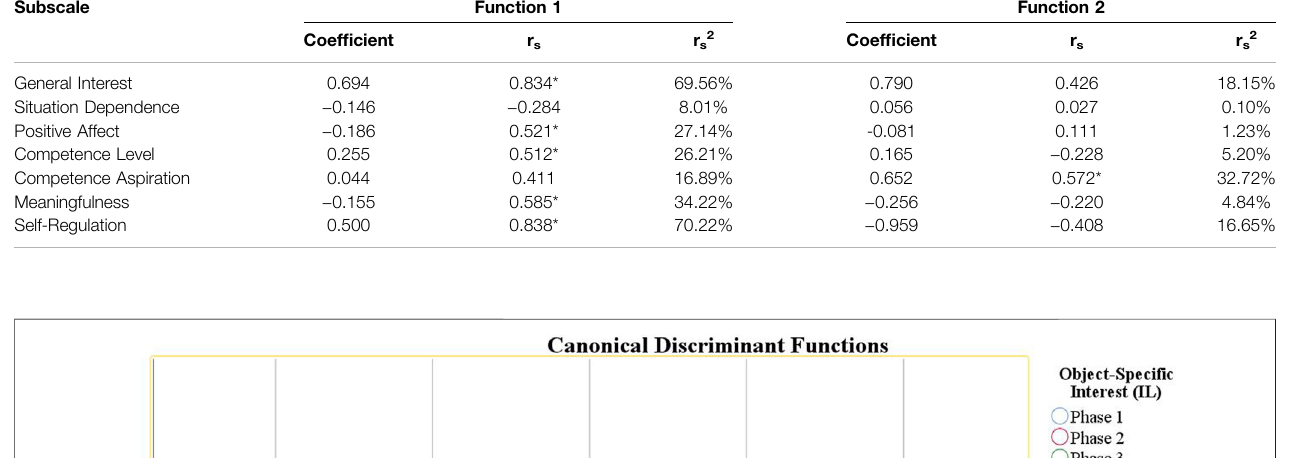
TABLE 7 | Standardized discriminant function and structure coef fi cients for the four phases of interest in IL. Subscale